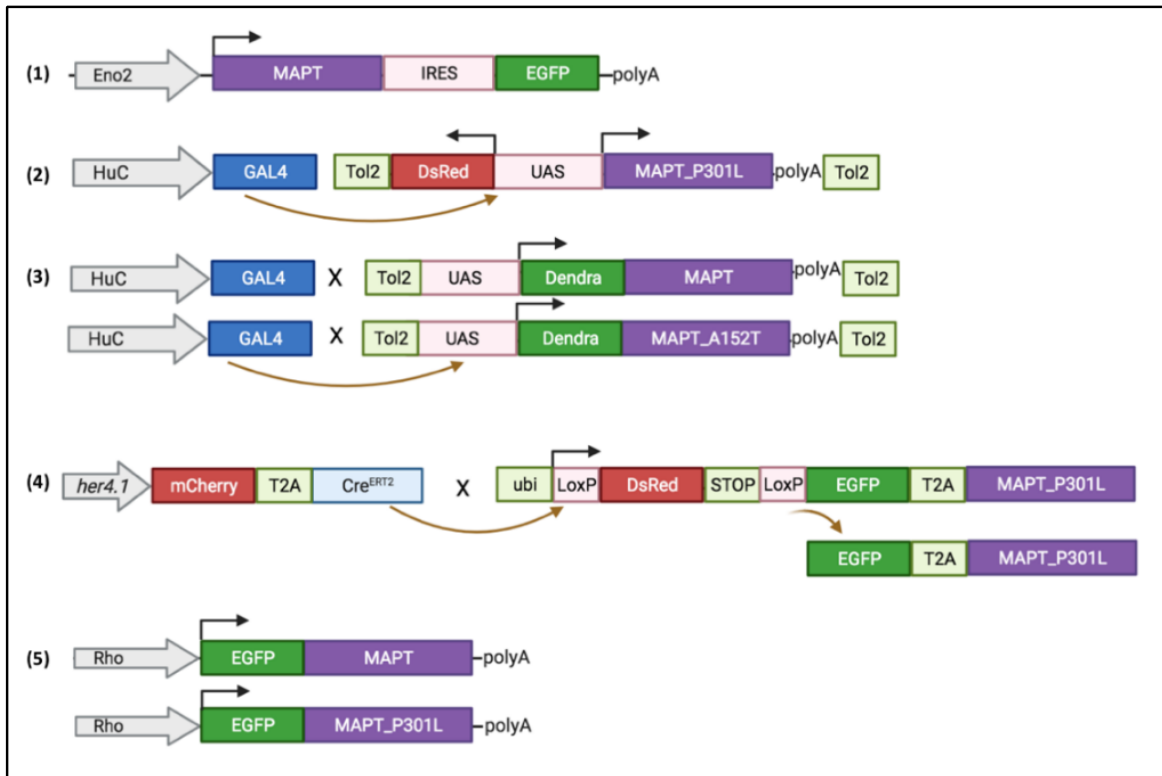
Figure 2. Transgenes used to generate stable lines. ( 1 ) Human MAPT 4R isoform is expressed under Eno2 promoter [29]. ( 2 ) Double transgenic line using Gal4/UAS system: Gal4 is expressed under HuC promoter and bind to bidirectional UAS promoter to induced the expression in the same neuron of DsRed and hTauP301L proteins [30]. ( 3 ) Using HuC promoter driving Gal4 line cross with UAS-driven fused Dendra:MAPT or Dendra:MAPTA152T results in neuronal expression of human proteins Dendra-hTauWT or Dendra-hTauAT52T [31]. (4) Conditional transgene using CreERT2_LoxP recombination: tamoxifen incubation results in expression of 2 proteins: EGFP and hTauP301L in her4.1 positive neural stem cells [32]. (5) Retina expression of MAPT or MAPTP301L driven by rhodopsin (Rho) promoter [33,34].